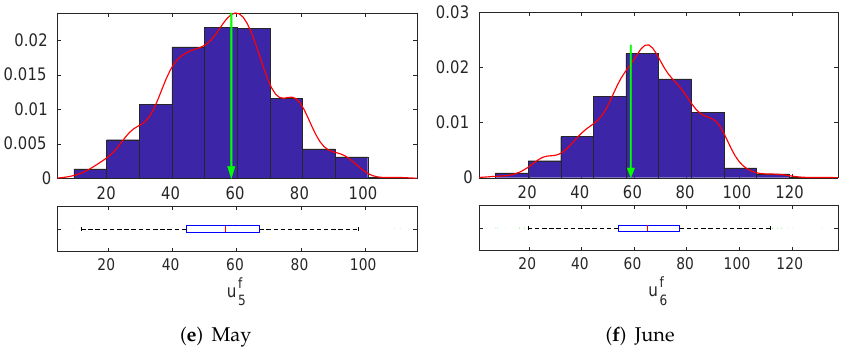
Figure 7. Distributions of the output LH associated to input parameters of CLM4 drawn by the a posteriori distributions: January–June.